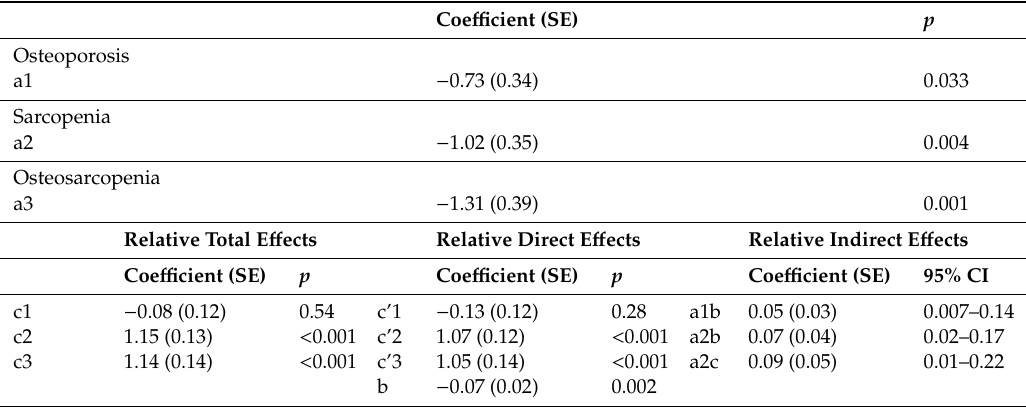
Table 4. Multicategorical mediation model: relative direct, total and indirect e ff ects for the mediating role of nutrition on the relationship between osteosarcopenia, osteoporosis and sarcopenia with